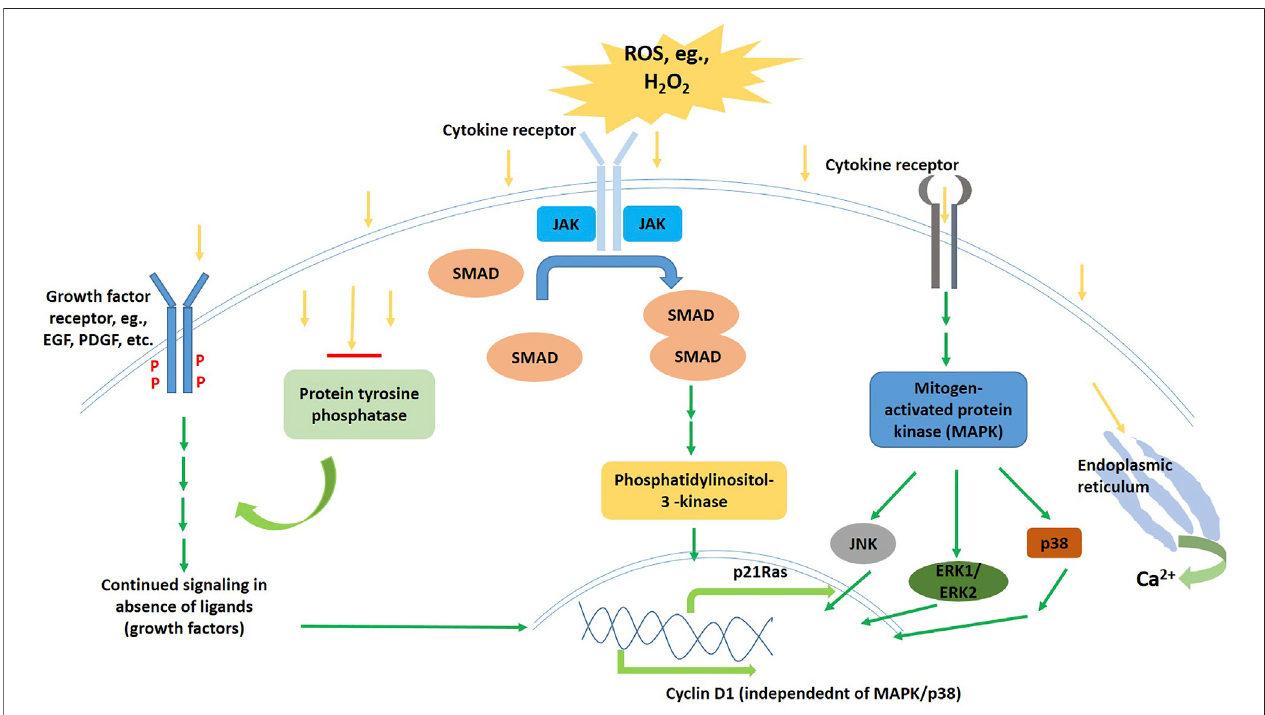
FIGURE 3 | Schematic diagram of the Wnt signalling pathway in the inactive (left) and the active (right) states.